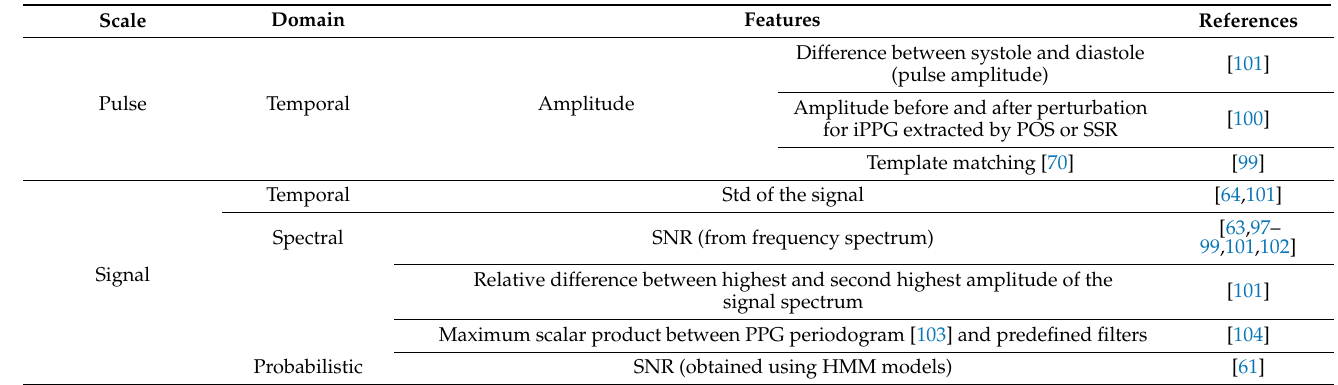
Table 8. Features used for the evaluation of